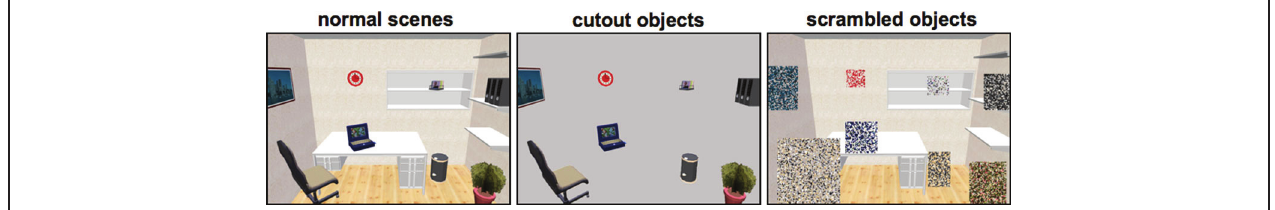
FIGURE 1 | Example stimuli used in the experiment . Stimuli from the study by Unema et al. (2005) were used and adapted into two additional variants (cut-out objects and scrambled